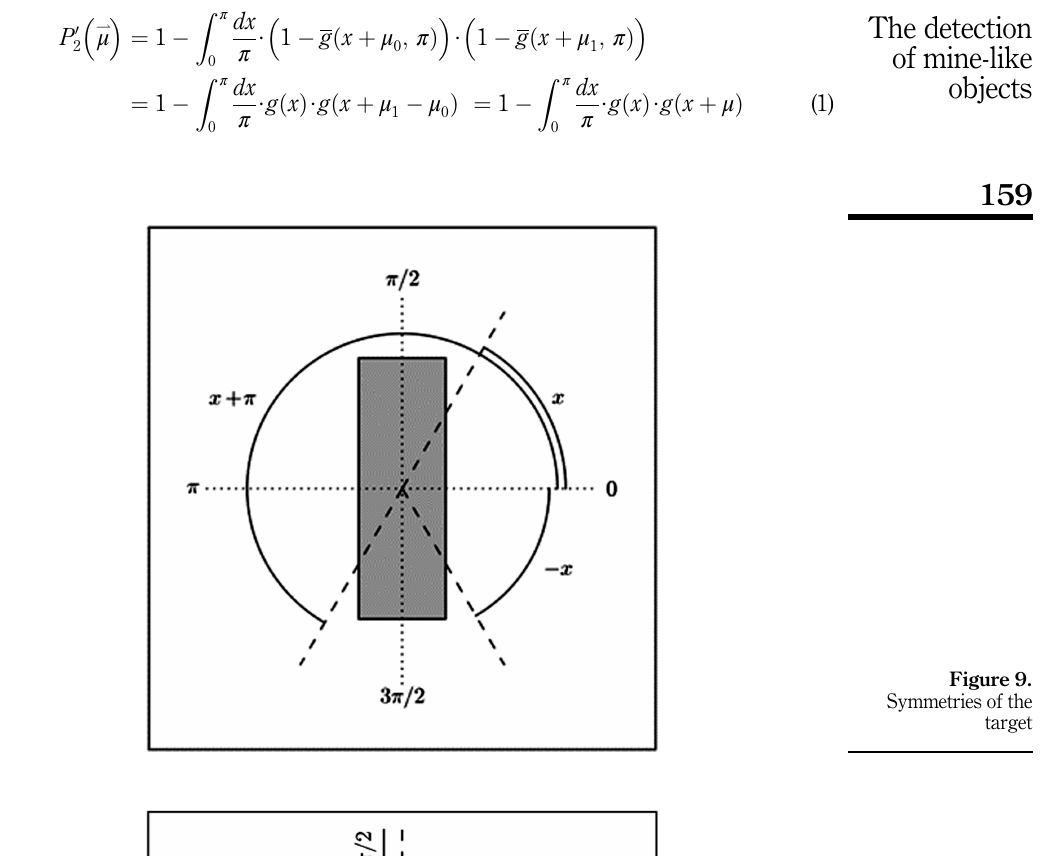
Figure 9. Symmetries of the